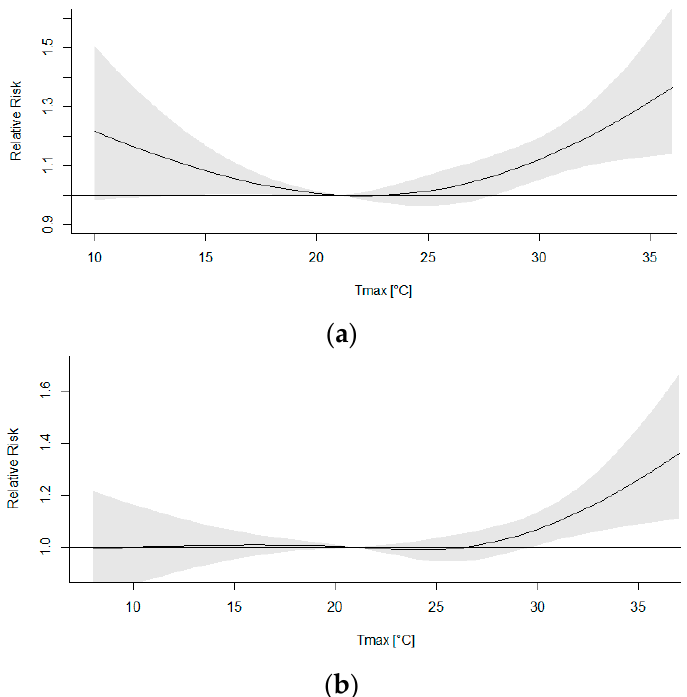
Figure 6. Relation between daily maximum temperature and relative mortality risk (all non-accidental causes) in warm months (June–September) for towns with population of 25–50 thousand during 2001–2016: ( a ) Wielkopolska; ( b ) Małopolska.